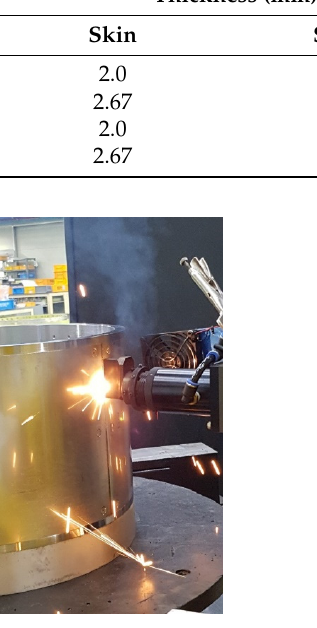
Figure 7. Photo of laser welding.